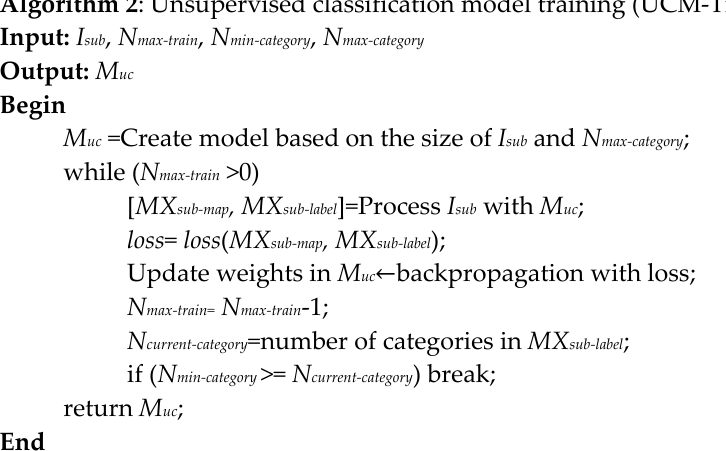
Algorithm 2 : Unsupervised classification model training (UCM-Train)